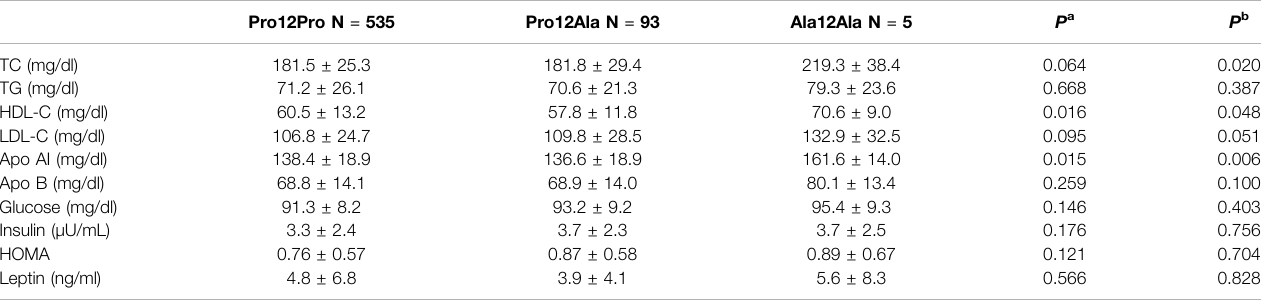
a p -value for comparison between the three genotype groups using Kruskal-Wallis test. b p -value for comparison under a recessive model for the Ala allele using Mann-Whitney U test.